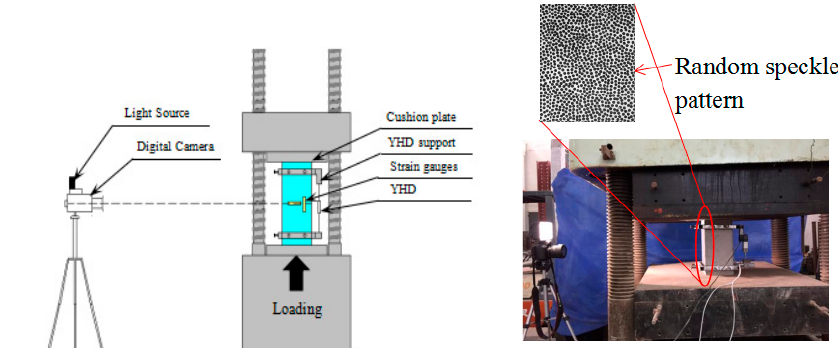
Figure 2. The testing device and instrumentations.